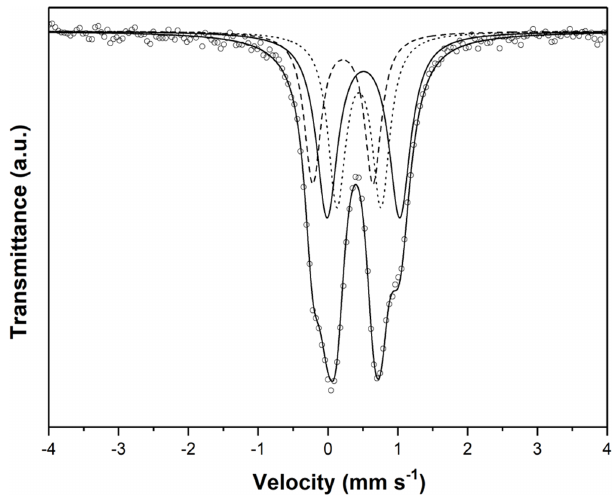
Figure 6. Mössbauer spectrum of beraunite from Hrbek (sam-